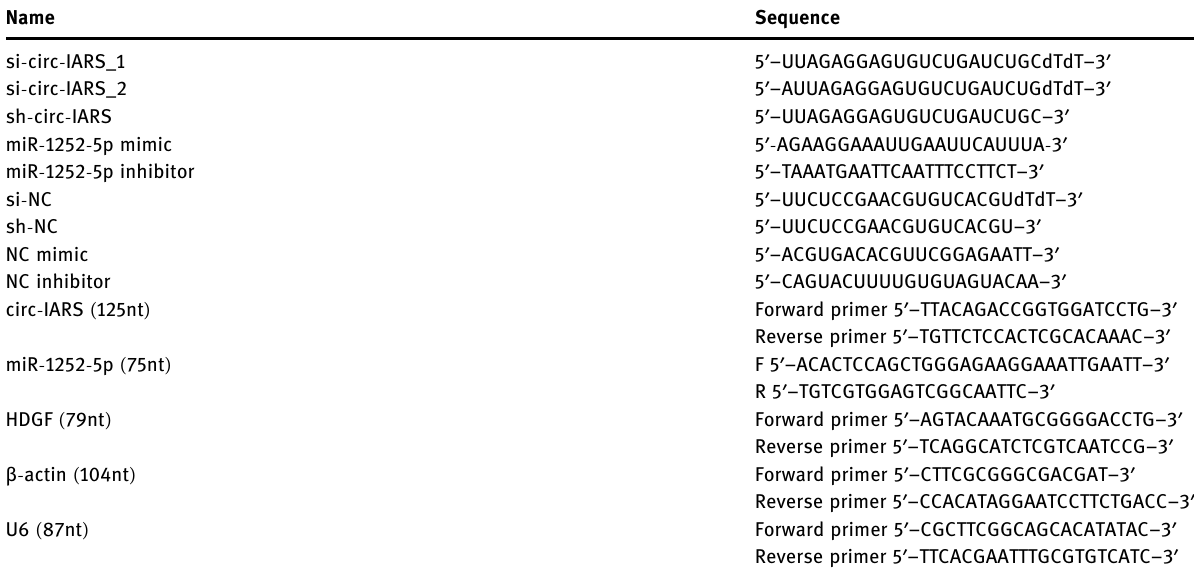
Table 1: Sequences of oligos and primers